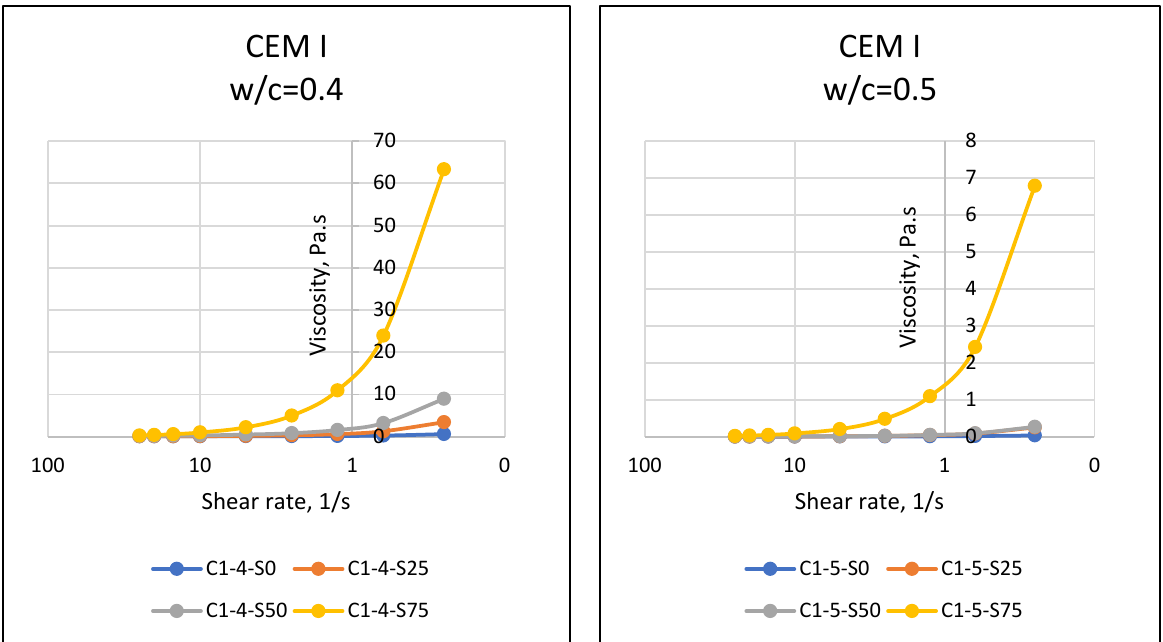
Figure 2. Viscosity–Shear Rate Relationships of SAPCPs with CEM I (w/c = 0.40 and 0.50).